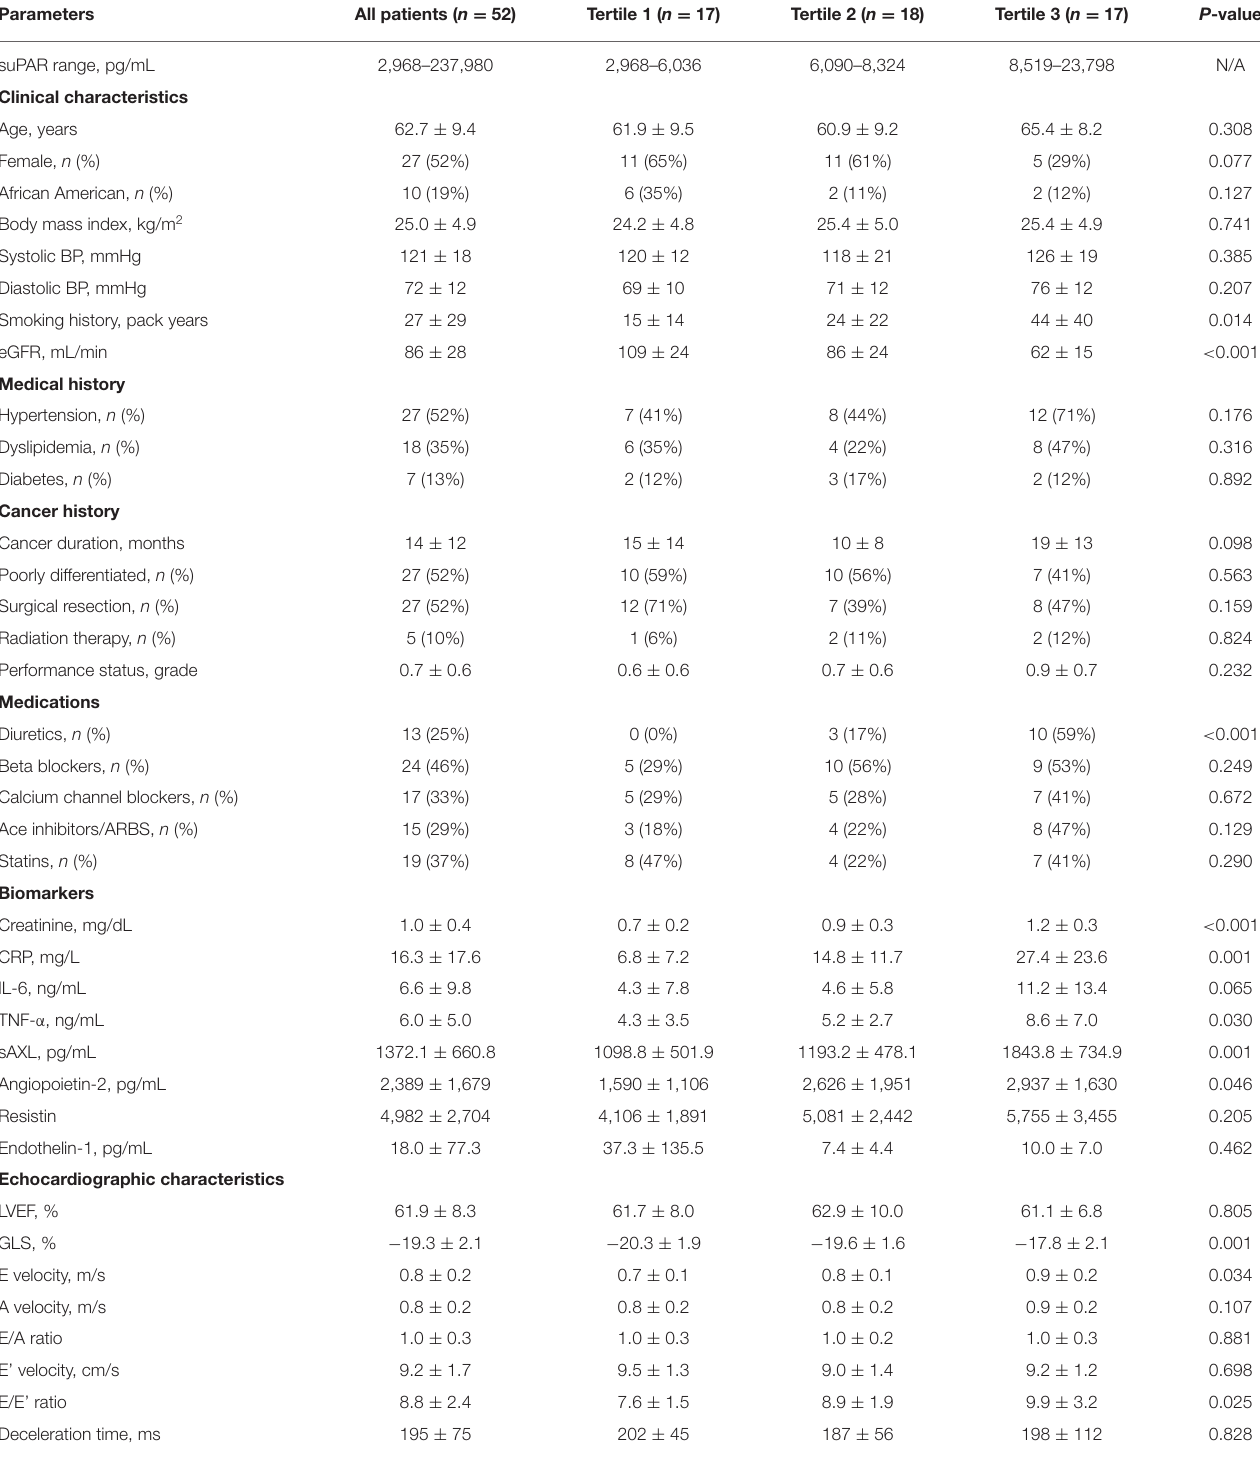
TABLE 1 | Baseline characteristics according to suPAR